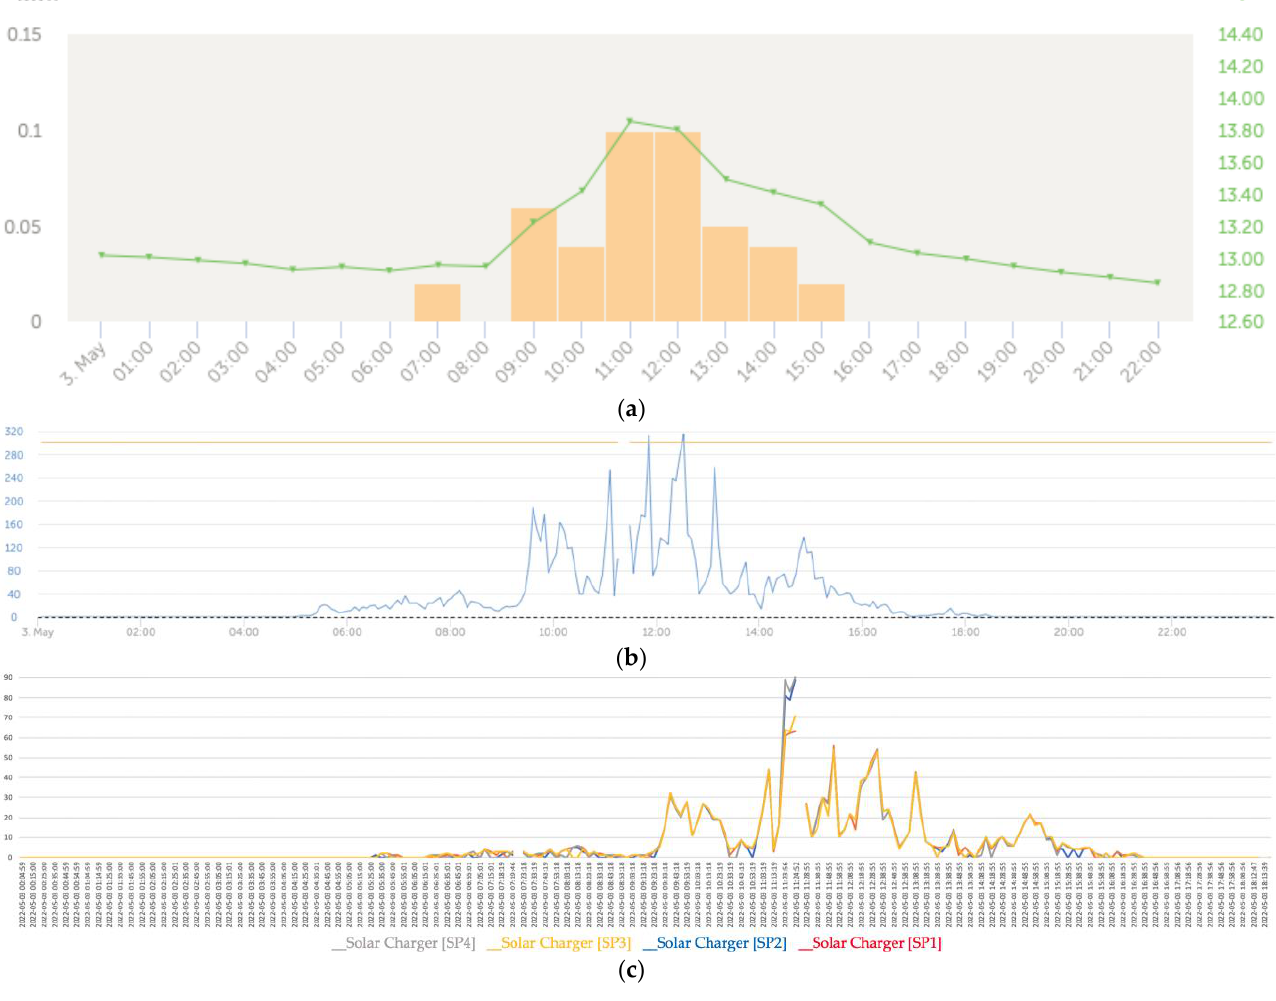
Figure 21. ( a ) Daily charge phases: initial, absorption, and flotation (3 May). ( b ) Solar irradiance (3 May). ( c ) Dense cloudiness blurred the shading effect, causing the convergence of the series (3 May).